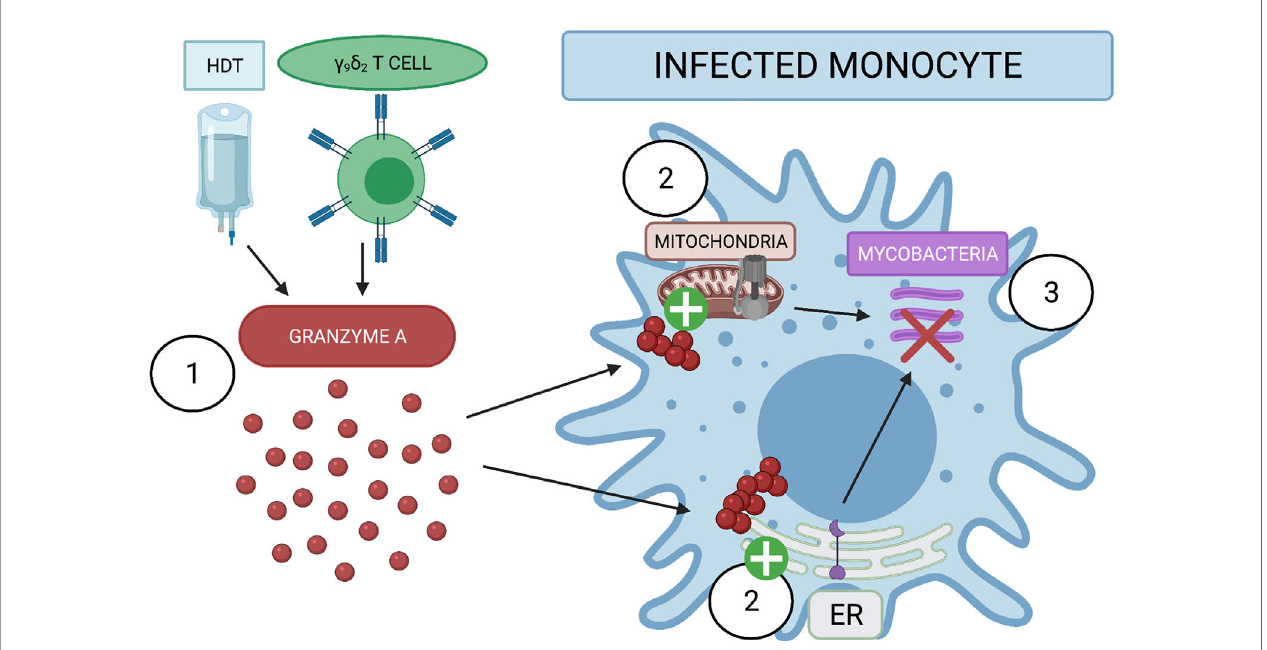
FIGURE 5 | Extracellular GzmA added to infected monocyte induce mycobacterial inhibition by activating ER stress response and ATP producing proteins. (1) GzmA protein is released into the extracellular environment of infected monocytes either as an Host Directed Therapy (HDT) or from secretion of g 9 d 2 . GzmA is internalized and does not appear to cleave any cellular substrate. (2) GzmA instead activates ATP producing proteins and the ER stress response to induce (3) the inhibition of intracellular mycobacterial growth. Created with